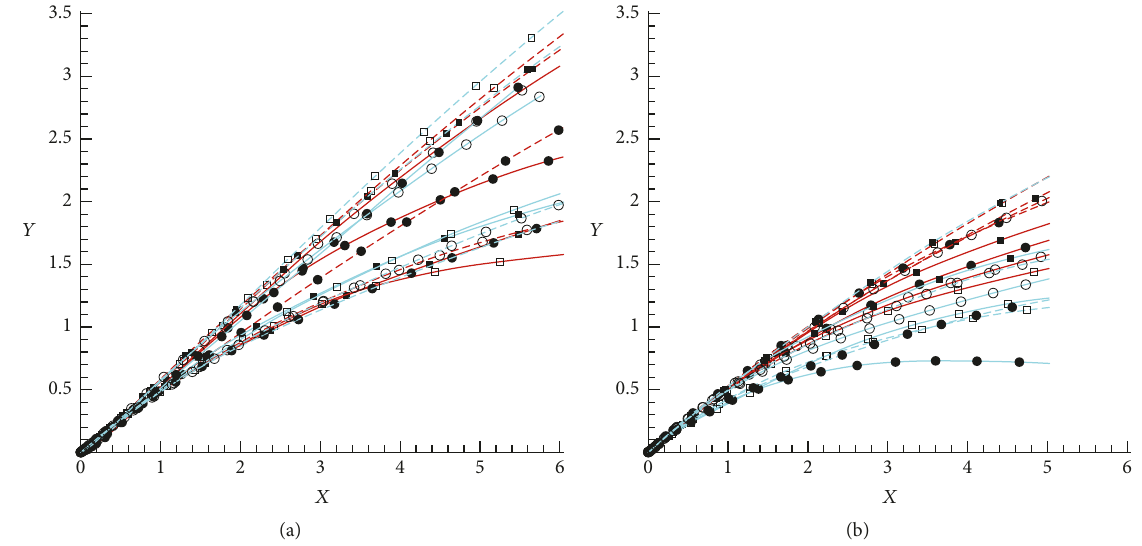
Figure 9: Dimensional trajectories representative of the test matrix for a positive starting angle of the plate; Red Fr number 51.7 ; Blue Fr number 66.6 ; square Re number 8750 ; circle Re number 5250 ; filled symbols K 37.5 ; empty symbols K 22.5 ; line inertia parameter 8.52×10 −2 ; dashed line inertia parameter 8.35 × 10 −2 .